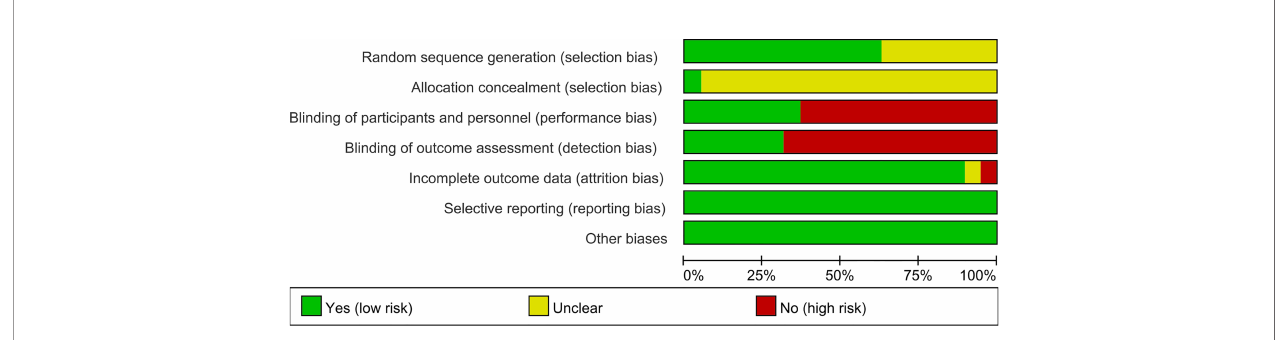
FIGURE 2 | Risk of